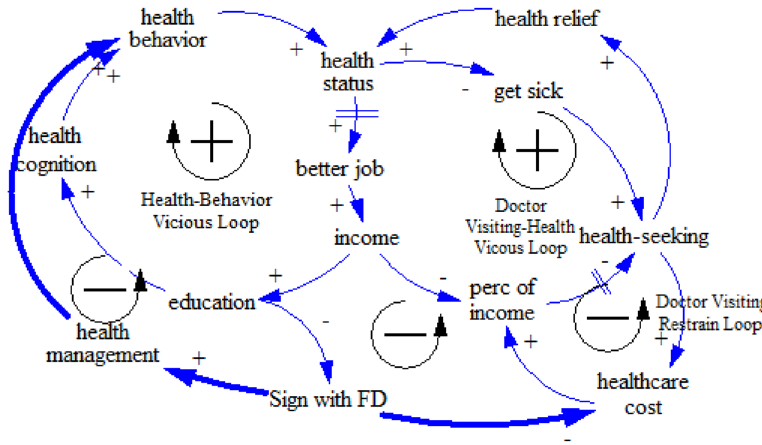
Figure 2. Causal loop of SES–family doctor (FD)–health disparity.